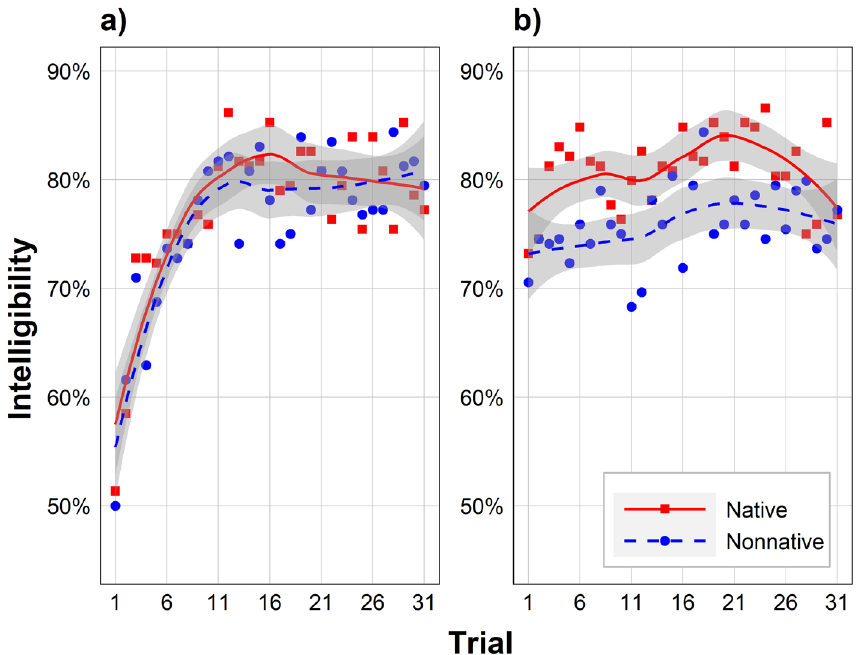
Figure 1. Effects of Accent and Trial on intelligibility. Intelligibility is shown for Block 1 ( a ; left) and Block 2 ( b ; right). Data points represent the mean of a condition across participants, lines are smoothed local regression lines of best fit (loess curves; for visualization purposes only), and gray shading represents the 95% CI. Within each block, the two accents represent two distinct groups of participants. Participants with the native accent in Block 1 (red line) become those with the nonnative accent in Block 2 (blue line), and vice